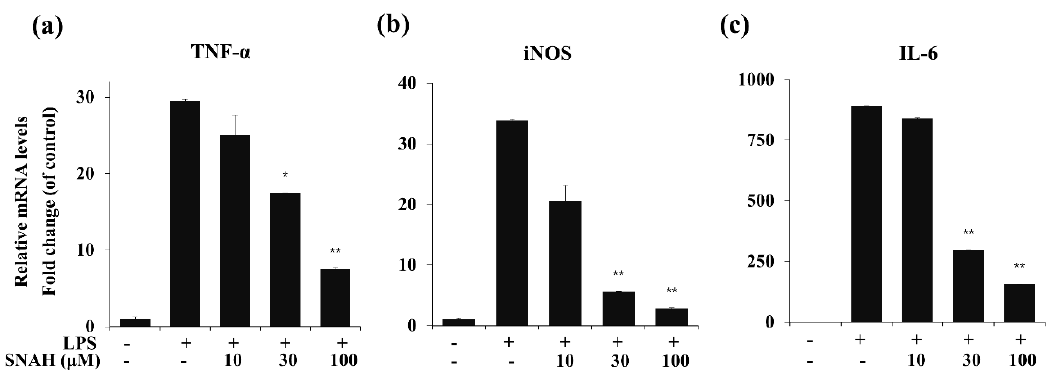
Figure 4. E ff ect of SNAH on TNF- α , iNOS, and IL-6 gene expression in RAW 264.7 cells. RAW264.7